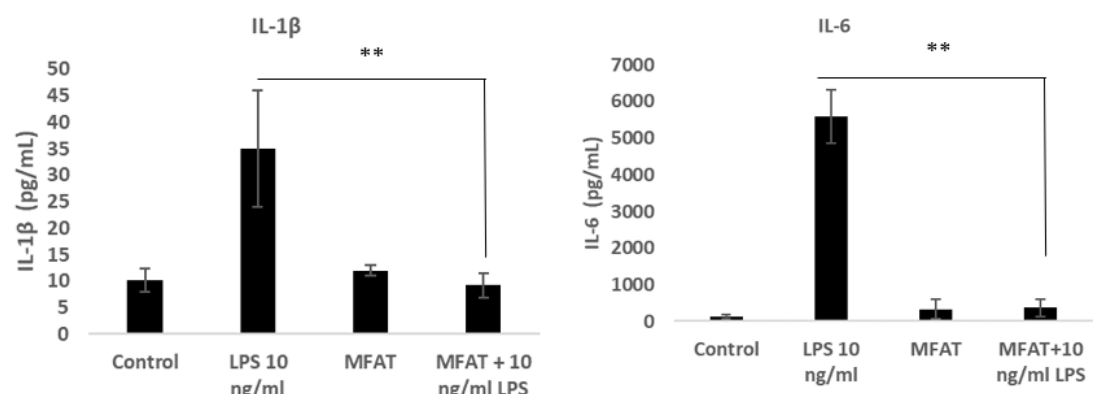
Figure 6. The inhibitory effect of the MFAT condition medium on the LPS mediated cytokines secretion MFAT conditioned medium indicated a significant inhibition on LPS (10 ng/mL) mediated IL-1ß1 secretion ( p < 0.01 **). ( A ); the MFAT condition medium indicated a significant inhibition of LPS (10 ng/mL) mediated IL-1 β ( p < 0.01 **). ( B ); Il-6 expression. n = 5 samples tested from the day five conditioned medium of MFAT cultures by an